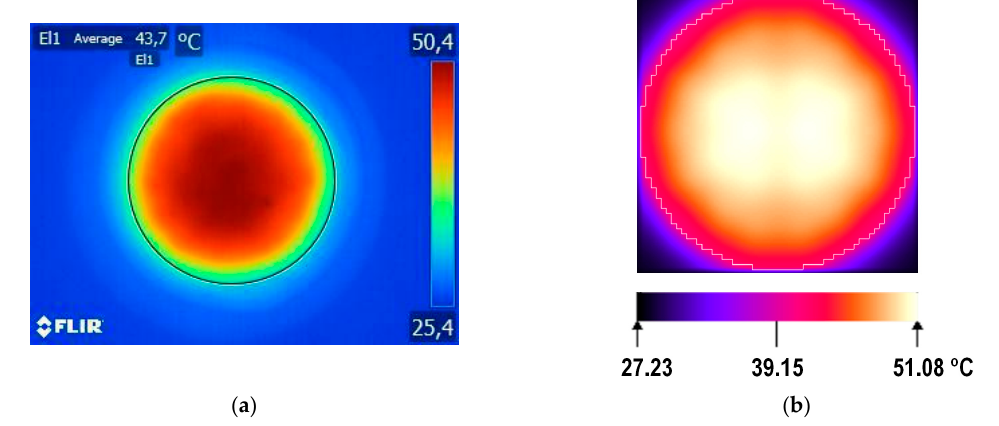
Figure 29. Steady-state temperature distribution at the top surface of the investigated CoB device at 100 mA driving current: ( a ) measured; ( b )